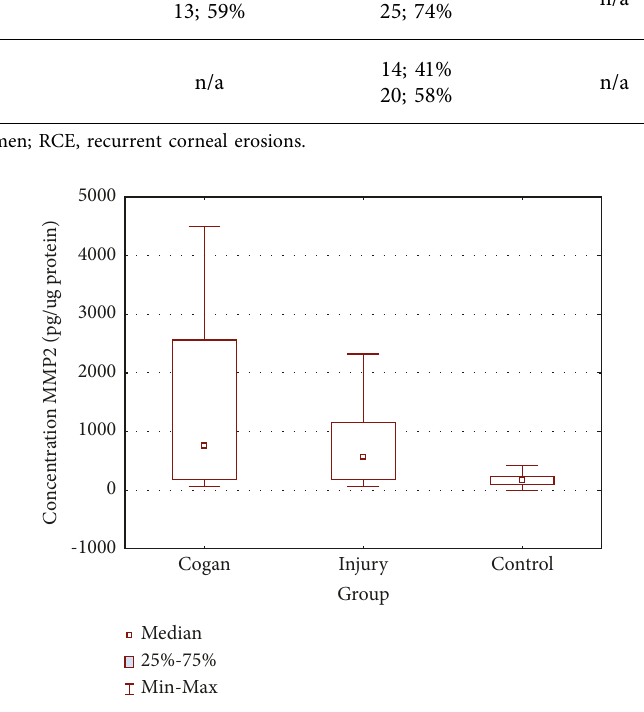
Figure 2: MMP-2 concentration values in the studied Table 2: MMP-2 and MMP-3 concentration values in the analyzed groups.